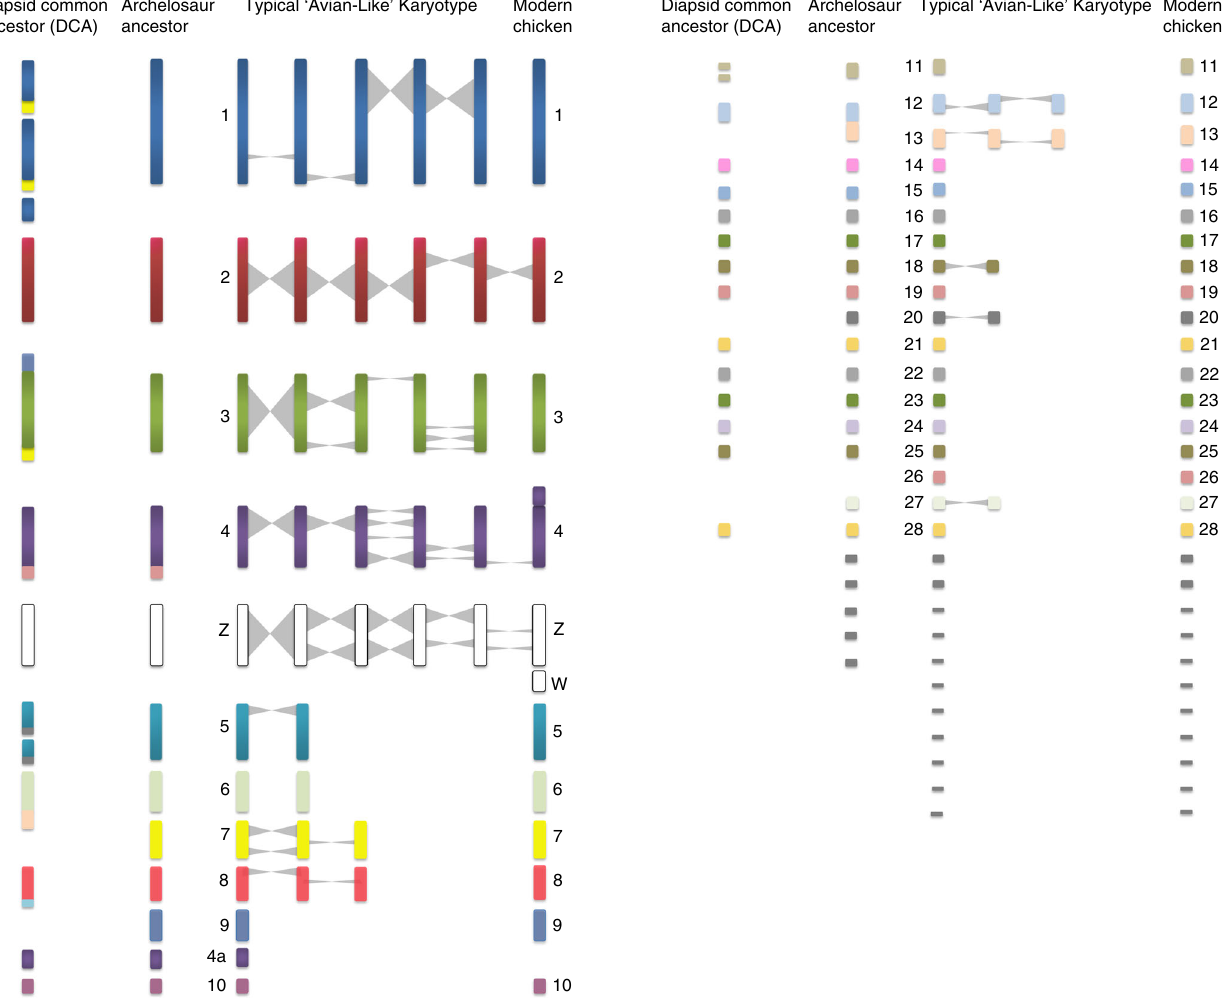
Fig. 2 Overall inferred karyotypic changes from the diapsid common ancestor (DCA), through the archosauromorph ancestor, modern chicken (2 n = 78) arising out of theropod dinosaurs, collating all available lines of evidence, bioinformatic and molecular cytogenetic. The left side shows the 19 CARs including the ancestral microchromosomes, which gives an impression of a higher diploid number greater than 46 (total chromosome number predicted) as we cannot necessarily determine the nature of all the fusions. For simplicity, the intrachromosomal rearrangements (inversions) are all depicted after the archelosaur ancestor, however, a small proportion may have occurred before. The colour scheme is randomly assigned with each chromosome for which we have data given a different colour. Chromosomes for which we do not have FISH data are depicted in grey (e.g. chromosomes 16, 20, 22 and the very smallest microchromosomes). Diapsid common ancestor (DCA): 255 mya; likely 2 n = 36 – 46; 19 CARs identi fi ed (some CARs likely fused as single chromosomes, hence this diagram appears as apparently more chromosomes; some chromosomes not covered by sequence assembly; Chromosome 7 orthologue (yellow) attached to three chromosomes, chromosome 26 (dark pink) to the orthologue of chromosome 4). Archelosaur ancestor: <255 mya ; likely ~2 n = 66; most chromosomes syntenic to modern birds; chromosomes without direct evidence (including chromosome 16, 20, 22) depicted in grey. Typical ‘ Avian-Like ’ karyotype: likely ~2 n = 80 (numbering according to chicken genome); ~7 fi ssions; some inversions may have occurred before the pattern was established interchromosomally, but intrachromosomal changes shown separately for clarity. Modern chicken: 2 n = 78; known fusion of chromosome 4 shown (not present in most birds); sex chromosome evolution post Palaeognathae – Neognathae